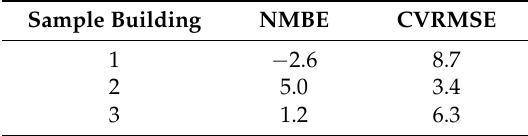
Table 5. Statistical indicators for the sample buildings.